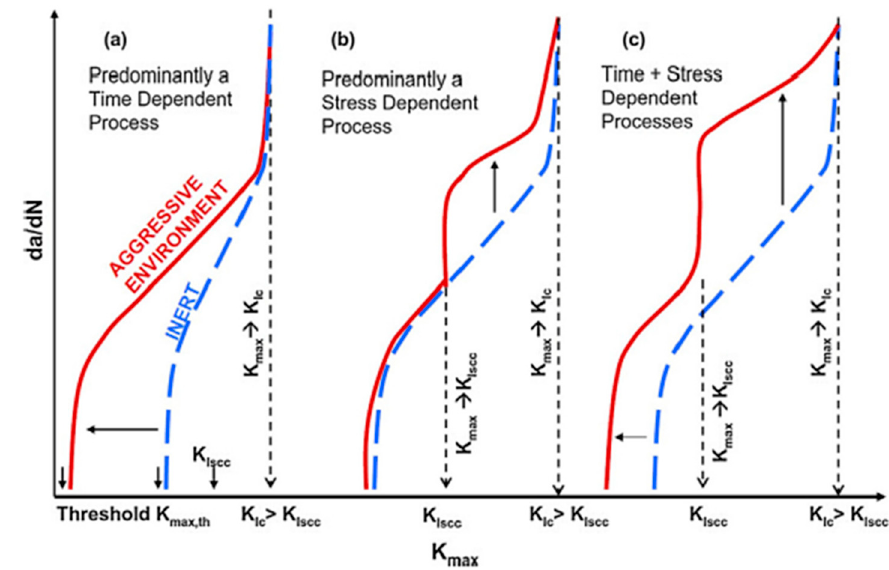
Figure 14. Schematic representation of crack growth rate under different combinations of static and dynamic loading in inert and corrosive environments. Crack growth rate depending on stress intensity factor in ( a ) pure corrosion fatigue (CF), ( b ) stress and ( c ) time-stress dependent SCC and CF combinations. Reproduced with permission from [115], Elsevier, 2009. Table 3 Frequency range for orthopaedic applications. Modified from [60]. Implants Frequency (Hz) Activity Orthopaedic 1–3 Normal walking (vertical direction) Orthopaedic 0.5–1.5 Normal walking (lateral direction)